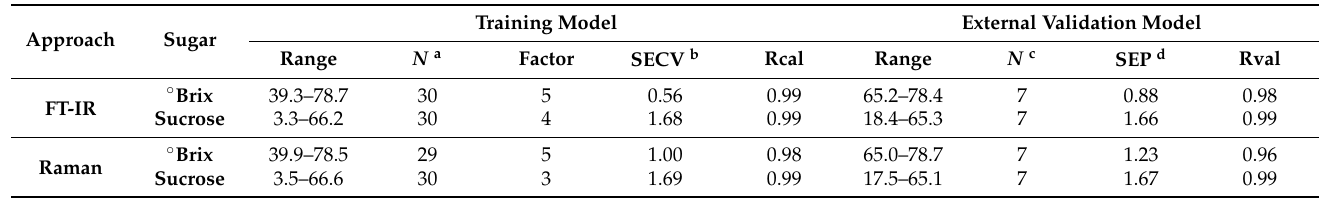
Table 2. Statistics of partial least square regression (PLSR) models developed using a training ( n = 30) and an external validation ( n = 7) data set based on FT-IR and Raman spectral data for estimating Brix and sucrose contents in traditional maple syrups, BBL maple syrups, and table syrup